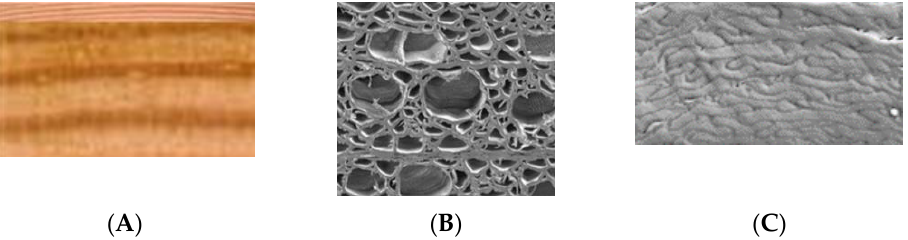
Figure 12. Effect of compression on specific gravity.